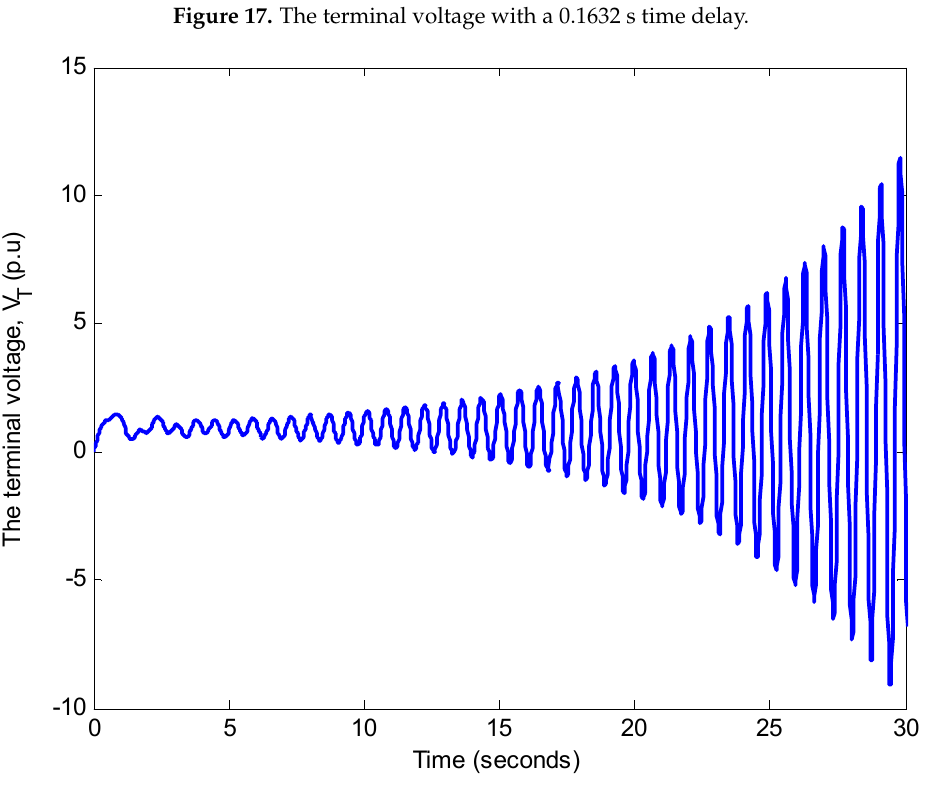
Figure 18. The terminal voltage with a 0.3 s time delay.